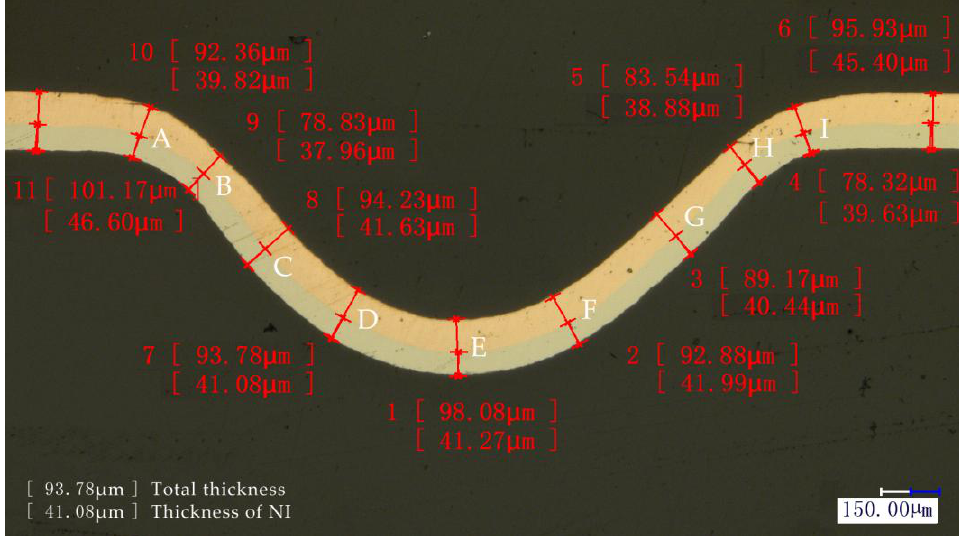
Figure 9. Measurement locations of thickness distribution.